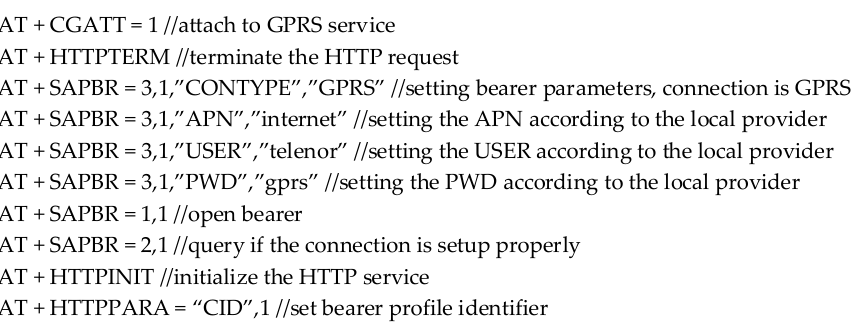
Figure 5. AT commands that are executed during the initialization procedure.